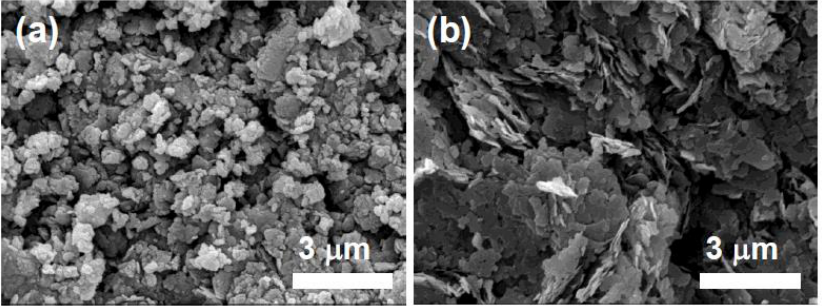
Figure 8. SEM images of Ca – Al – Fe LDH with Ca/Al/Fe ratios of ( a ) 8:1:3 and ( b ) 5:1:1.5.